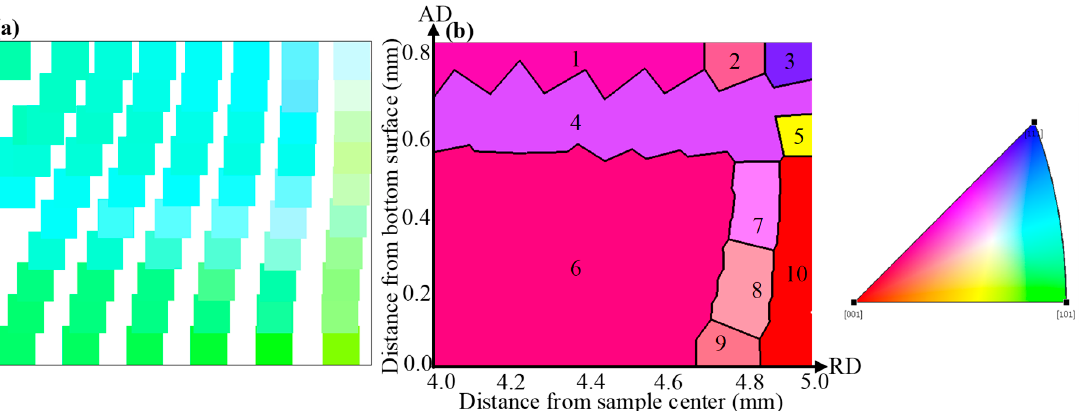
Figure 4. The predicted grain map recorded on the selected R - Z plane after ( a ) N = 1/16 turn HPT deformation, ( b ) N = 1/8 turn HPT deformation.